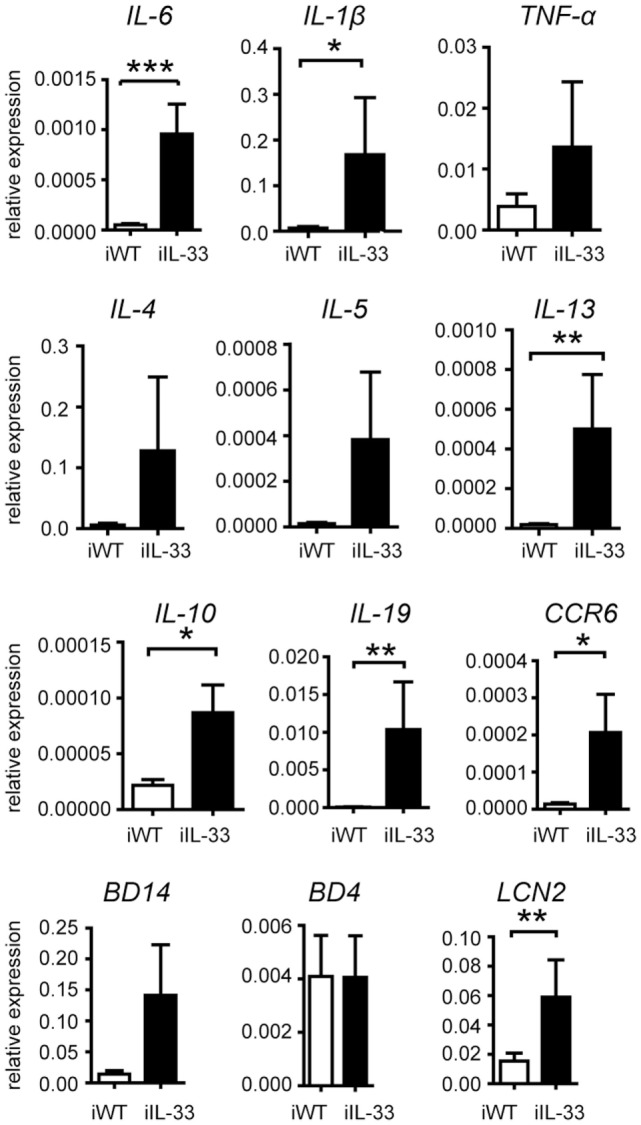
Changes in cytokine profiles of lesional skin of iTg. cDNA isolated from the lesional skin of iTg compared to iWT after the administration of tamoxifen was analyzed for the expression of the respective genes by quantitative real-time PCR. All data are given as mean ± SEM. *p < 0.05, **p < 0.01, and ***p < 0.001 (Mann-Whitney). Three independent experiments.